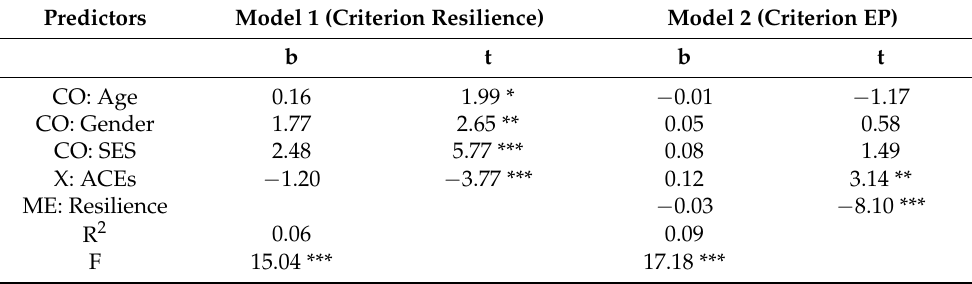
Table 3. Mediating effect of resilience on ACEs and preschoolers’ emotional